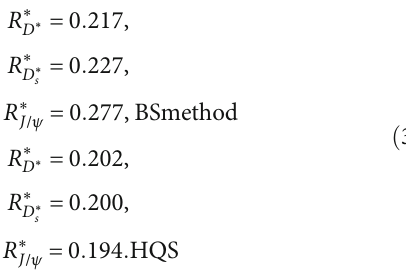
Figure 2: The q 2 -dependences of di ff erential decay rates d Γ / dq 2 (solid lines) and d Γ L / dq 2 (dashed